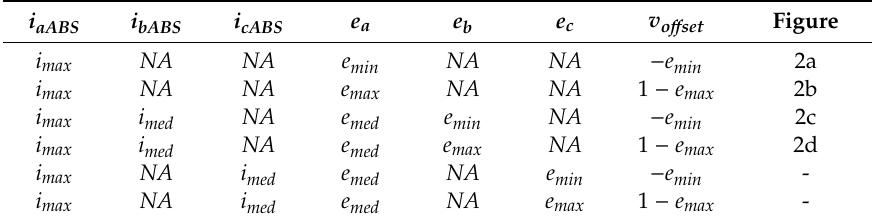
Table 2. The o ff set voltage of the 5L-HBT 2